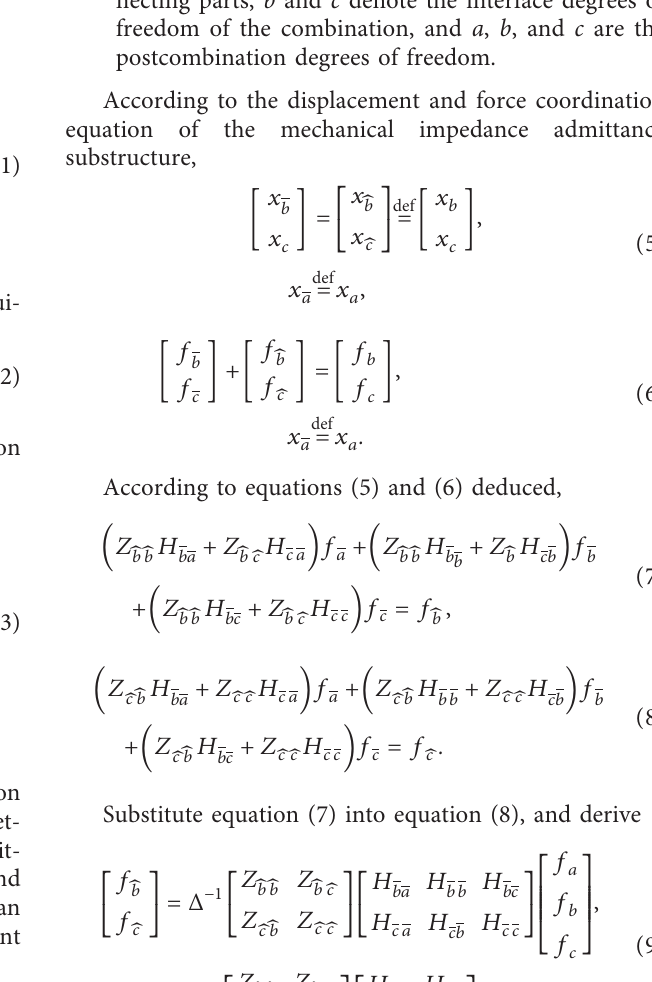
Figure 4: Dynamic substructure combined